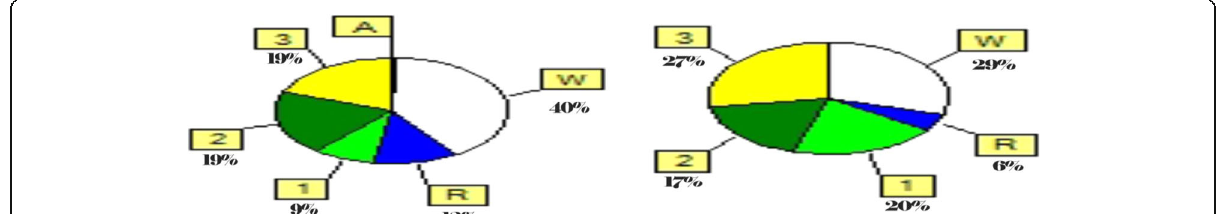
Fig. 1 Sleep stages from total sleep time (TST) in a Gullian Barré Patient early after hospital admission (left) with marked prolongation of waking after sleep onset (W) and shortening of each N2% and REM% of TST. One month after immunotherapy (right), the same patient showed mild improvement of sleep architecture but still not reaching the normal values